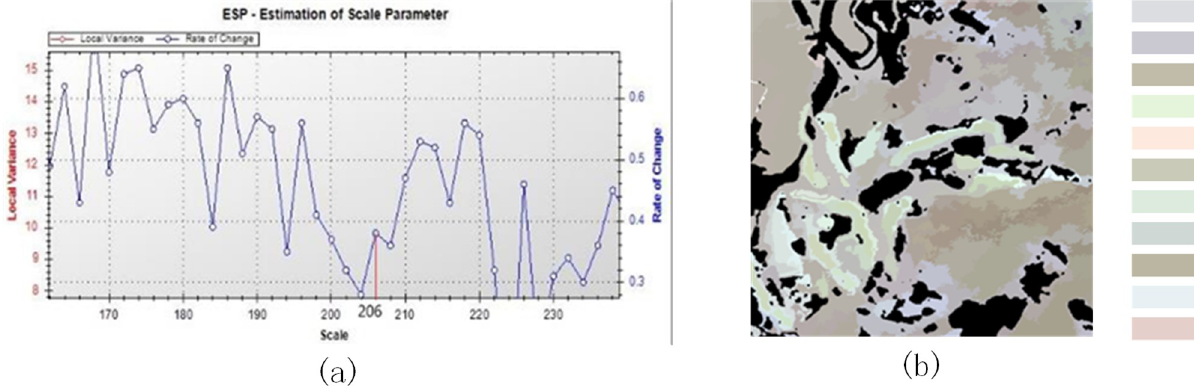
Fig 8. Multiresolution segmentation (SS = 206, WS_1 = 0.5, WC = 0.1): (a) variance curve and (b) image object.